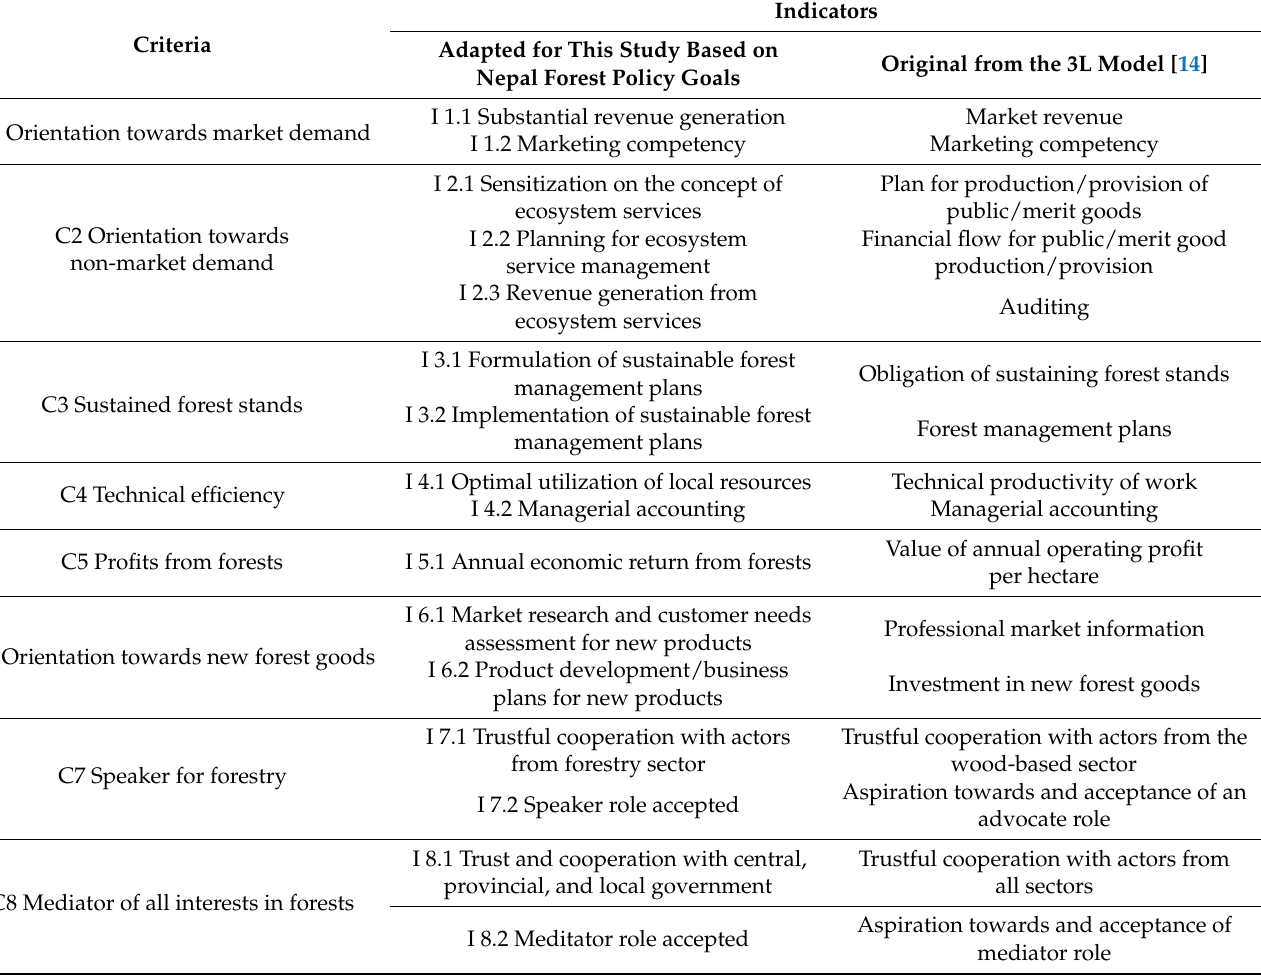
Table 1. Criteria and indicators for assessing the performance of community forestry in Nepal. Indicators Criteria Adapted for This Study Based on Nepal Forest Policy